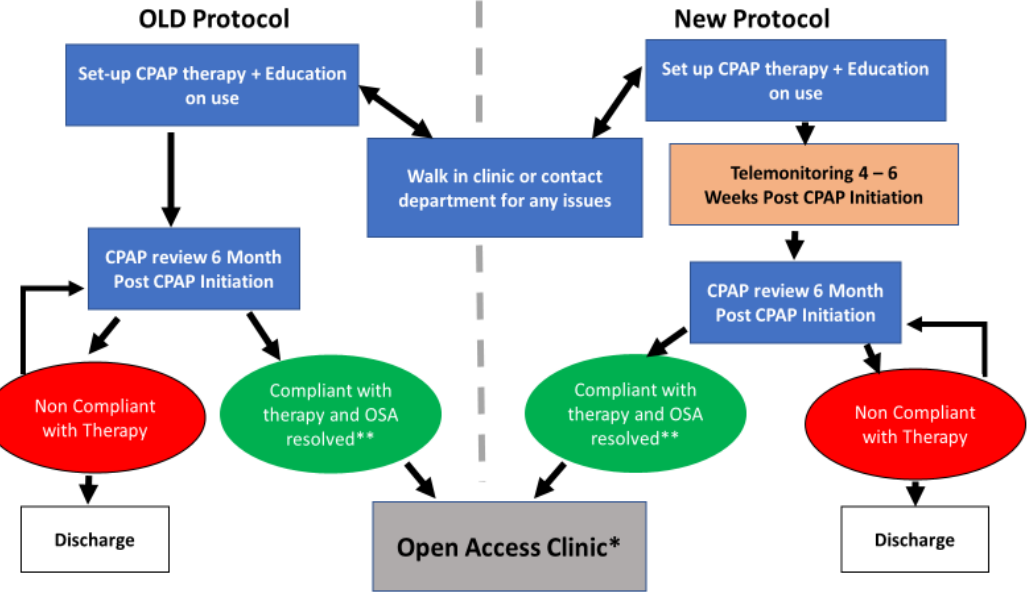
Figure 1. Illustration of the CPAP therapy management pathway; The old and new protocols were applied on the historical control and intervention arms in this service improvement project. OSA = obstructive sleep apnoea; * This patient does not have a routine CPAP follow-up appointment but can still access the CPAP walk-in clinic or get in touch with the physiology department for any issues with the therapy; ** Compliant with unresolved OSA might require further investigation or medical review. Table 1. Breakdown of CPAP data information and machine returns. Controls (% of Total) Patients able to have